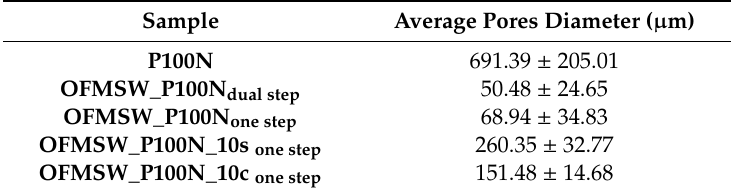
Table 4. Mechanical properties and density of dual step and one step process cured samples. Samples